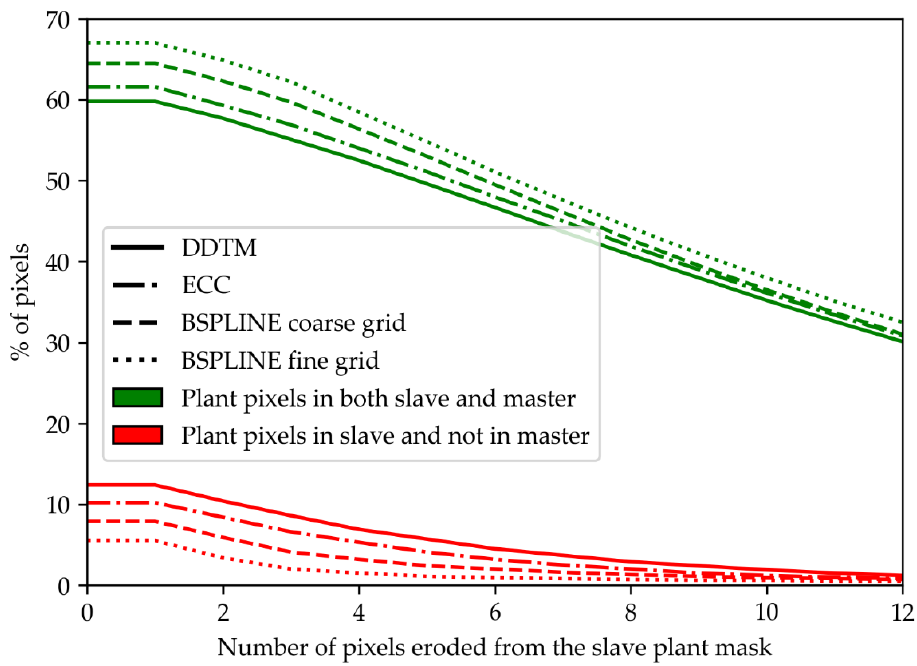
Figure 13. Impact of plant mask erosion for 900 nm images (the twelve images of the vegetative validation set) aligned using DDTM, ECC, B-SPLINE coarse grid (final grid spacing of 16 pixels) and B-SPLINE fine grid (final grid spacing of 2 pixels).